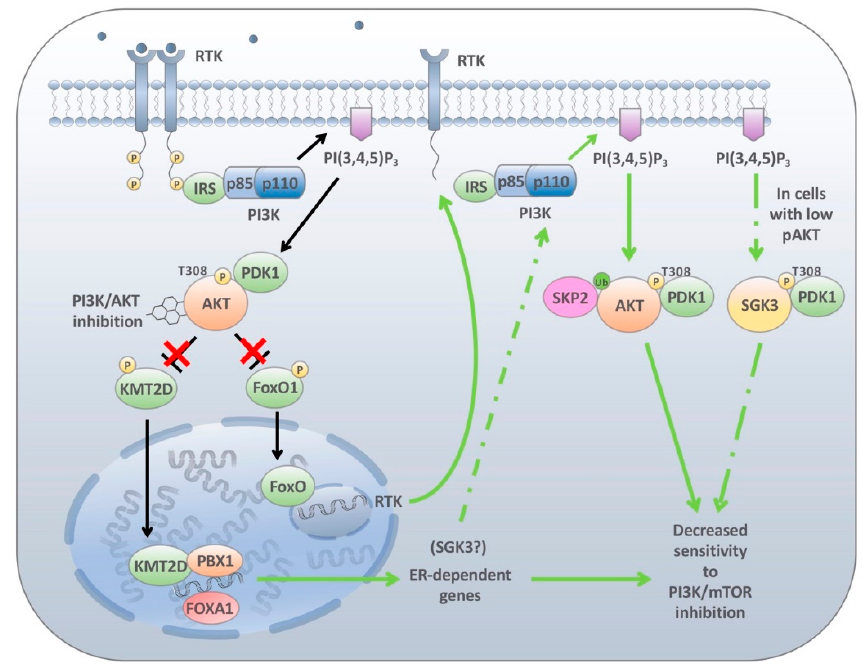
Figure 3. Adaptive and epigenetic-driven mechanisms of resistance to PI3K/AKT inhibition. A number of adaptive mechanisms regulating PI3K inhibitor sensitivity have been described. The most notable of which is the upregulation receptor tyrosine kinases (RTKs) following PI3K/AKT inhibition. Members of the FOXO family of transcription factors are direct substrates of AKT with phosphorylation limiting their nuclear localisation. Upon AKT downregulation FOXO is drawn into the nucleus where it is recruited to binding sites which upregulate a number of receptor tyrosine kinases including HER2 and HER3. This upregulation of these RTKs results in the enhanced activity of both MAPK and PI3K signalling pathways. Similarly, in ER+ breast cancers AKT phosphorylates the methyl-transferase KMT2D inhibiting the methyl-transferase activity of the enzyme. Upon AKT inhibition KMT2D activity is restored priming the recruitment of the transcription factors FOXA1, PBX1 and ER onto ER binding sites enhancing ER-dependent gene transcription and limiting the PI3K therapeutic effects. SGK3 is an ER transcriptional target. PIK3CA mutant tumours displaying low levels of pAKT can circumvent this by activating SGK3 and downstream mTOR signalling limiting the sensitivity of PI3K inhibitors.